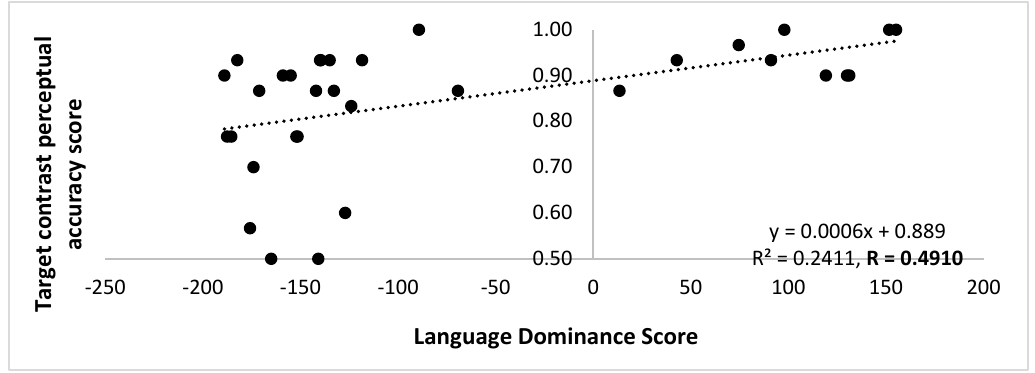
Figure 2. Scatterplot linear correlation between language dominance scores and target token perceptual accuracy scores. Positive scores indicate Spanish-dominance; negative scores indicate English-dominance.